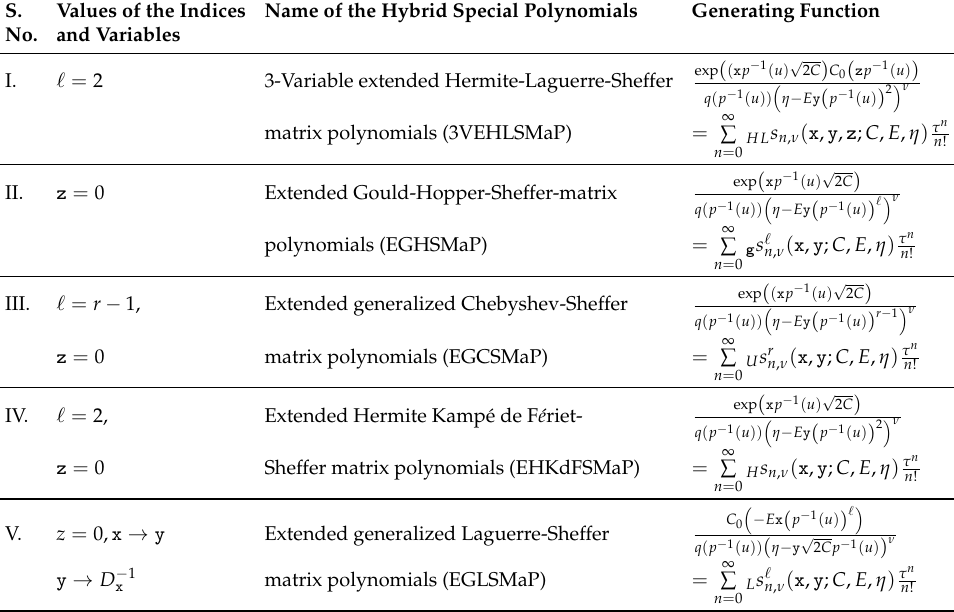
Table 2. Special cases of the EGHLSMaP g L s (cid:96) n , ν ( x , y , z ; C , E ; η ) .